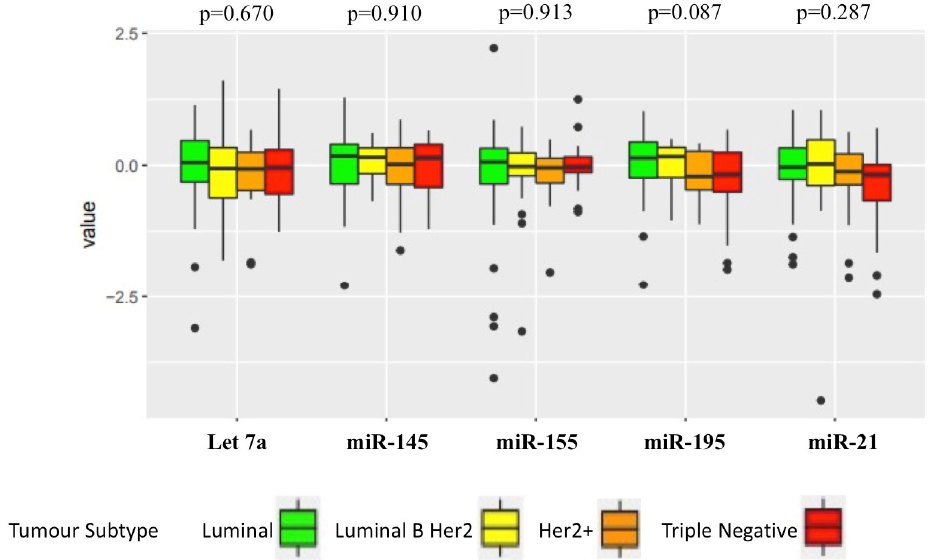
Figure 1. Levels of indicated miRNAs in the specified breast cancer subtypes. No significant association between the target miRNA level and any breast cancer subtype was found. Luminal, n = 57; Luminal B Her2, n = 20; Her2+, n = 14; Triple negative, n = 23.